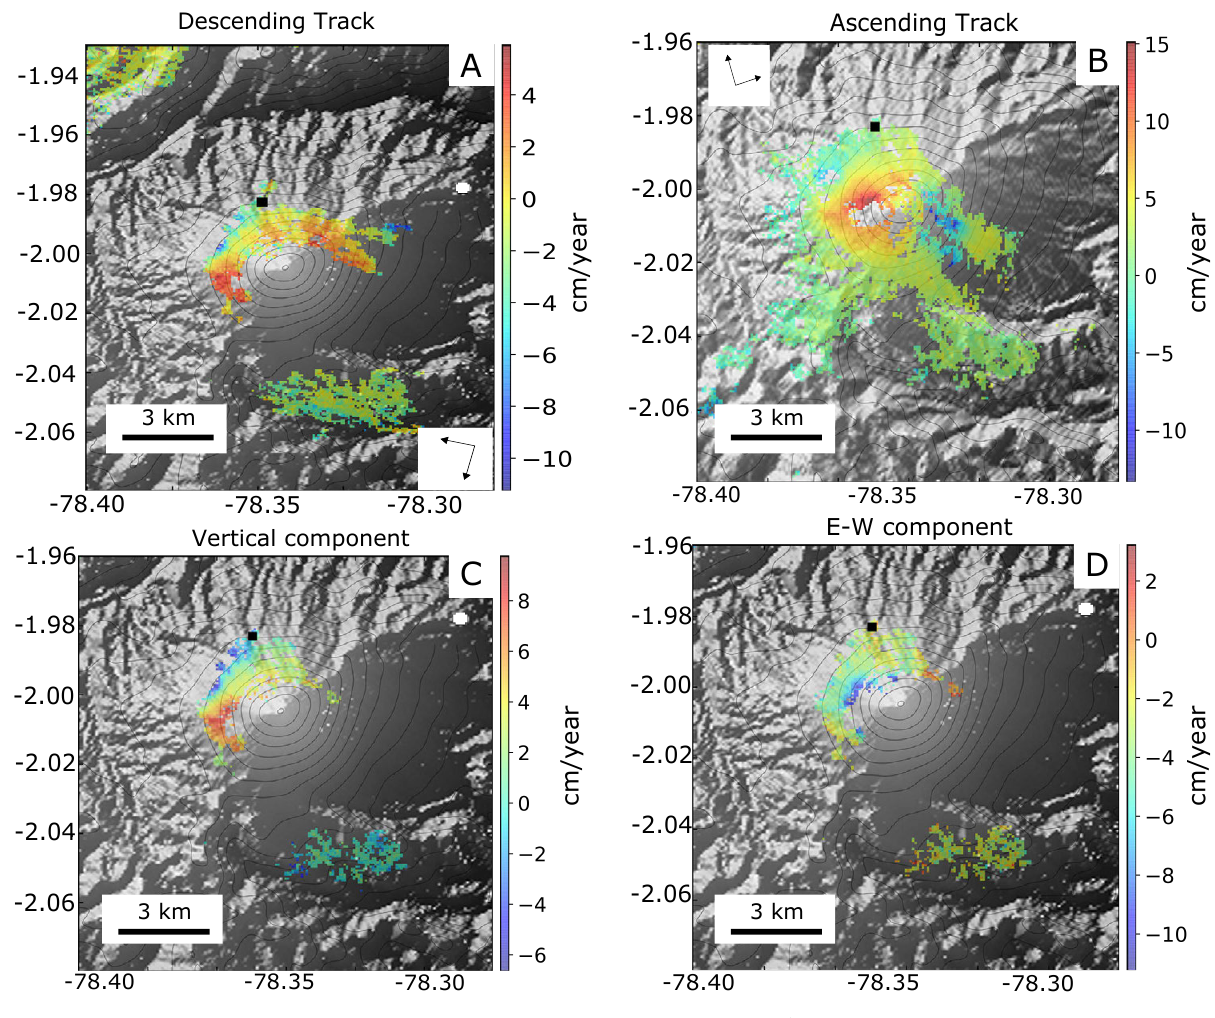
Figure 3: Results of deformation monitoring analysis obtained using InSAR, for the two years preceding the new northern lava flow onset. [A] Deformation along the LOS direction, Descending track between 05/01/2020 and 07/12/2021, [B] Deformation along the LOS direction, ascending track between 02/01/2020 and 04/12/2021. Components of motion: [C] Vertical component and [D] Horizontal component at Sangay volcano. The black square represents the reference